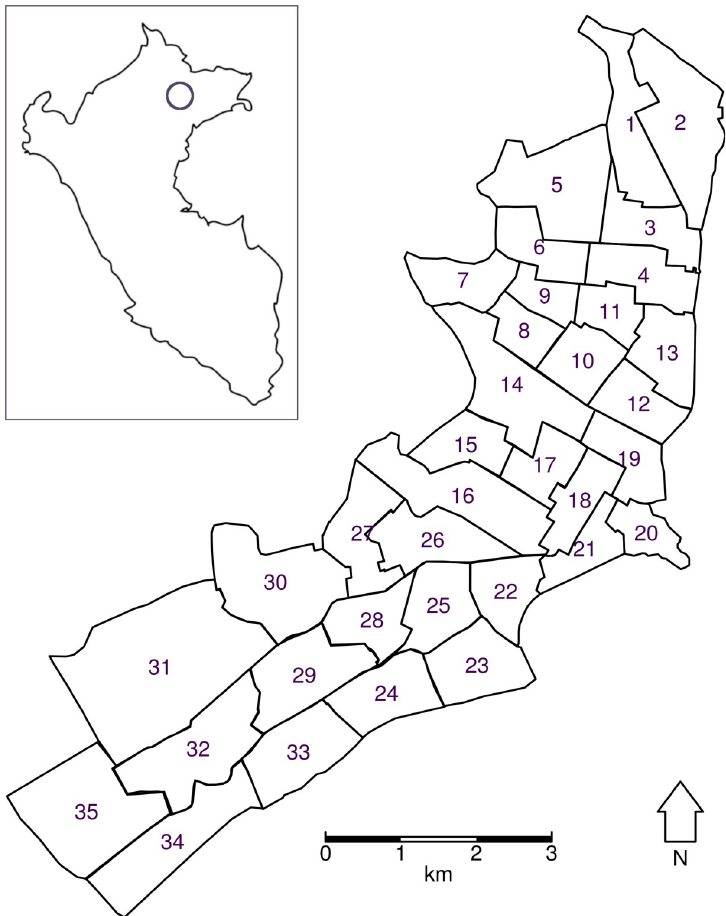
Fig 2. Map of Iquitos showing the boundaries of the Ministry of Health zones, which are numbered 1–35. Inset shows location of Iquitos in Peru. In the baseline scenario spraying begins in zone 1 and continues in ascending order through the zones. The inset map in this figure is taken from